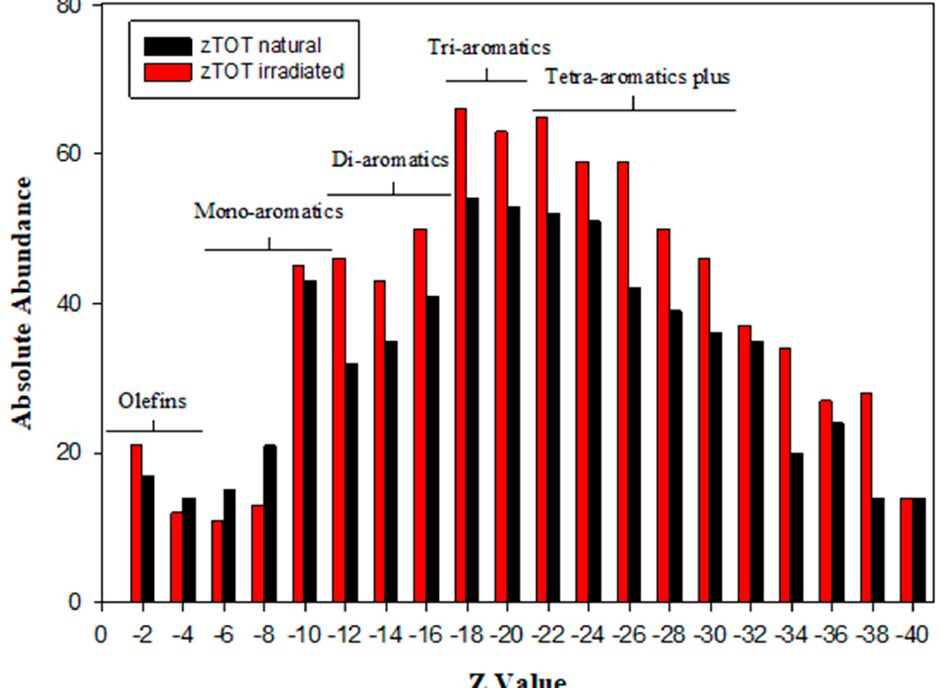
Figure 5. Oxygen class <Z>-distributions for natural and irradiated samples.